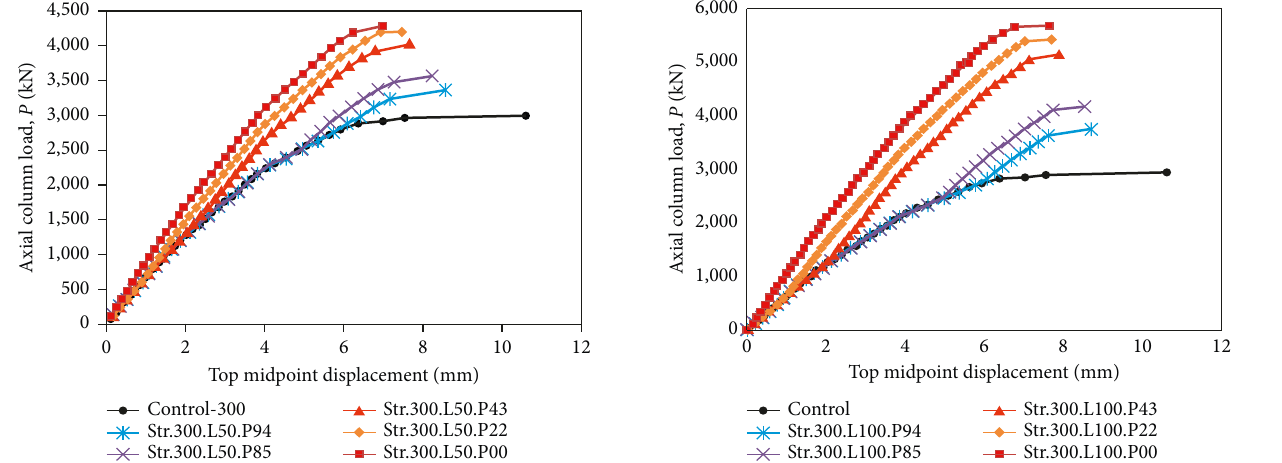
Figure 8: The curves relating to load displacement obtained from FE simulation for columns strengthened by 4L · 100 × 100 × 10 with different percentages of